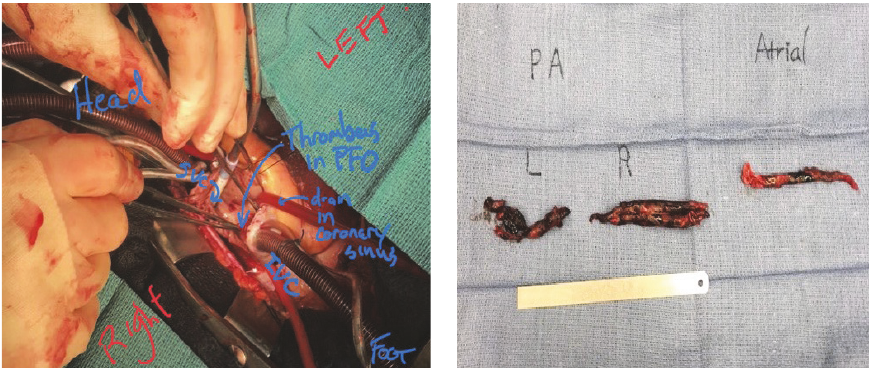
Figure 4: Photographs from surgical thrombectomy. Saddle pulmonary embolus was extractedfrom the pulmonary artery.The embolus that extended to all visualized segments of the branch pulmonary arteries was removed as well. The thrombus that was straddling the PFO was also removed en bloc. The PFO was surgically